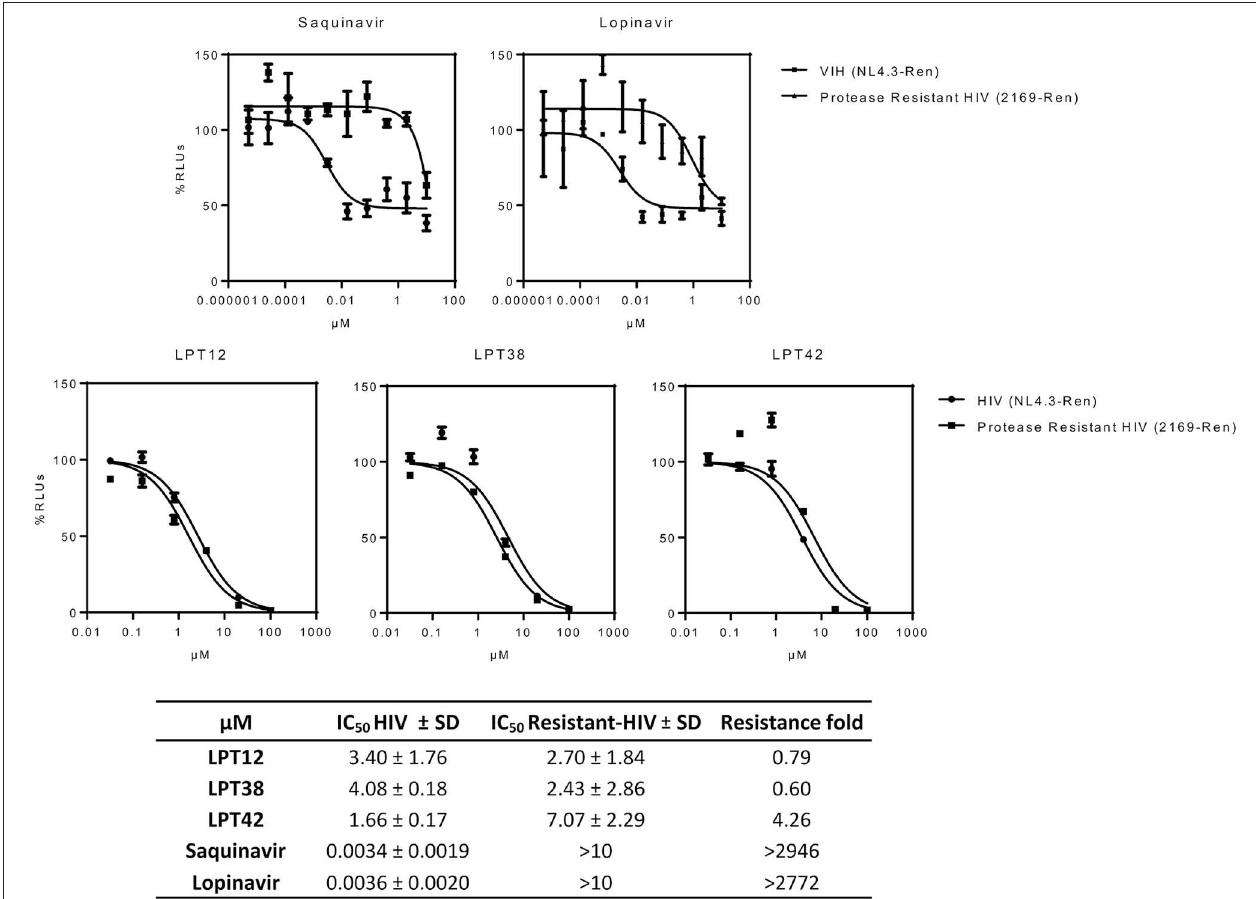
FIGURE 8 | Effect of LPTs on MT-2 infection with protease inhibitors resistant HIV-1 ( 2169-Ren) as compared to the wild type recombinant virus ( HIV NL4.3-Ren). Results are shown as percentage of RLUs as compared to an untreated control. IC 50 values were calculated with GraphPad Prism software, using non-linear regression analysis (Log inhibitor vs. response). SD, Standard